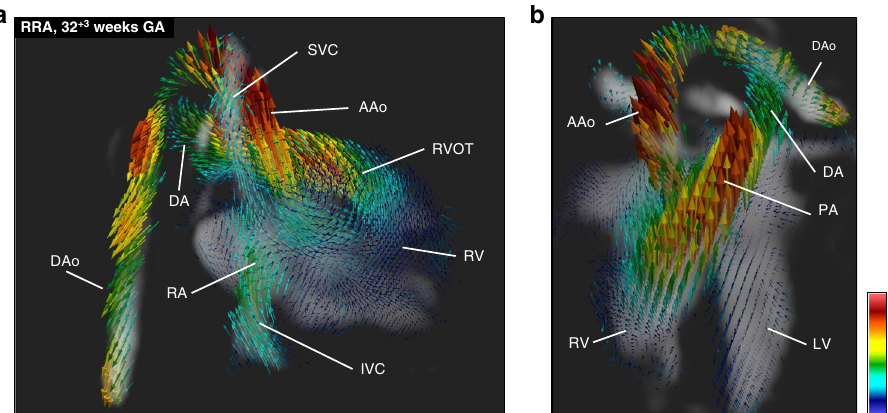
Fig. 5 Whole heart 4D blood fl ow in a fetus diagnosed with congenital heart disease. Volumetric 4D fl ow renders showing three-directional fl ow velocity vectors in subject ID06 (right aortic arch, fetus 32 + 3 weeks gestational age) overlaid on 4D magnitude cine renders, during end-ventricular systole. a Aortic arch view showing blood fl ow vectors emerging from the ascending aorta (AAo), fl owing around the arch and through the descending aorta (DAo). Flow through the ductus arteriosus (DA) is clearly visualized. b Long-axis view showing blood fl ow through the crossing AAo and pulmonary artery (PA). At this developmental stage the blood fl ow velocity vectors are considerably faster compared to the 24 + 2 weeks gestational age fetus in Fig. 4. The velocity scalebar is adjusted to re fl ect this. See supplementary information for movies of the views in this fi gure.